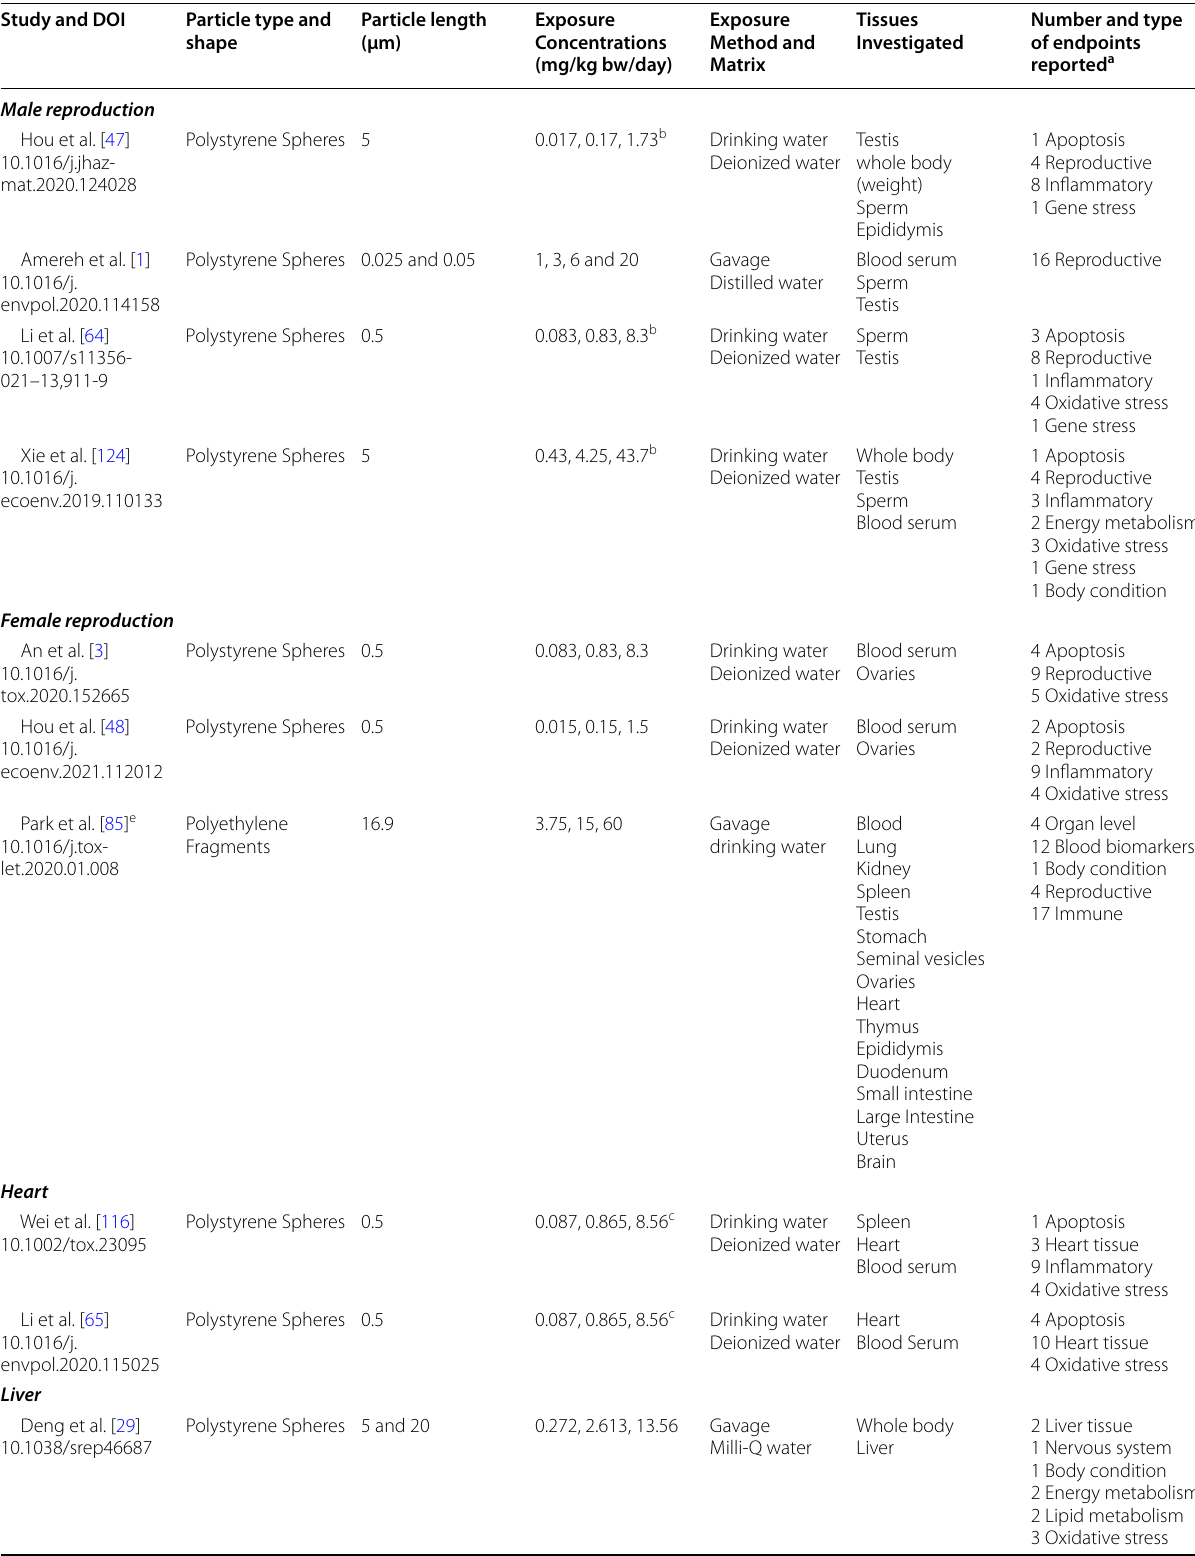
Table 2 Summary of in vivo ingestion-based mammalian studies prioritized for Tier 2 expert evaluation Study and